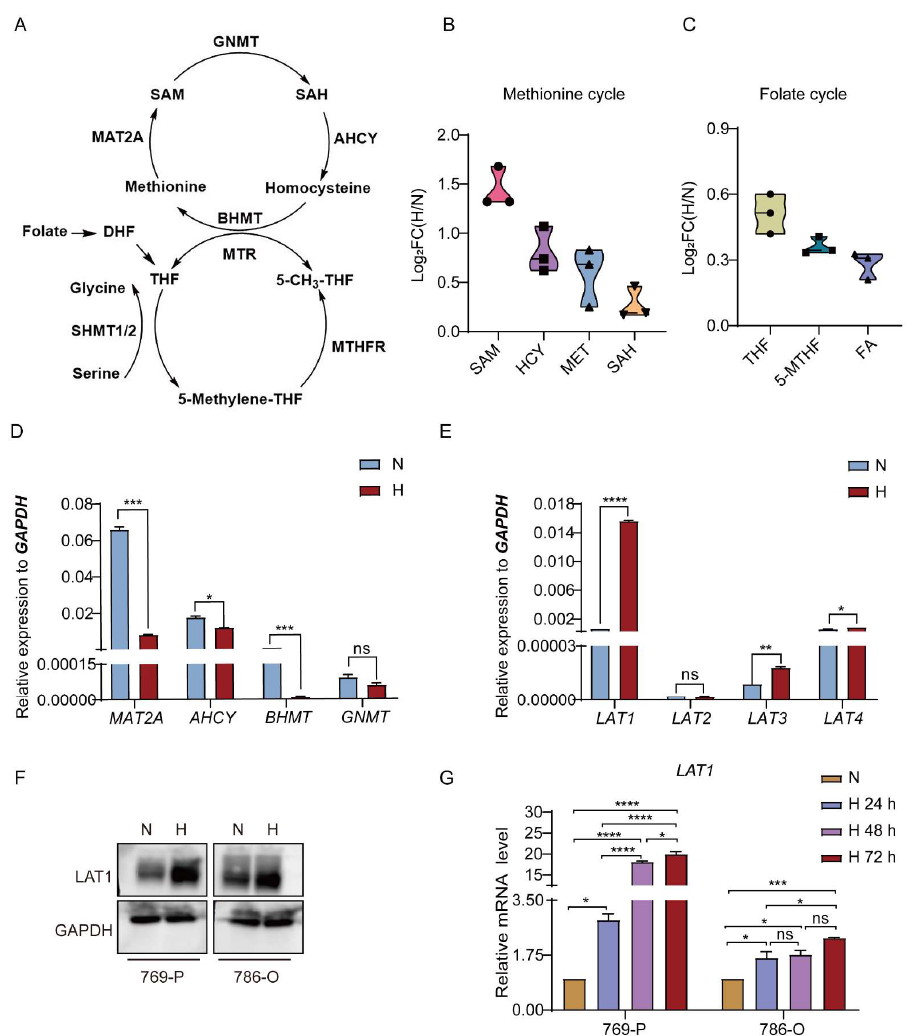
Figure 1. Increased methionine metabolism is mediated by LAT1 upregulation in RCC cells under hypoxia. ( A ) The schema of pivotal metabolites and enzymes in methionine cycle and folate cycle. ( B ) Relative amount of methionine (MET), homocysteine (HCY), S-adenosylhomocysteine (SAH), and S-adenosylmethionine (SAM) in 769-P cells cultured under normoxia and hypoxia for 72 h, respectively. ( C ) Relative abundance of tetrahydrofolate (THF), 5-methyl-tetrahydrofolate (5-MeTHF), and folate (FA) in 769-P cells cultured under normoxia and hypoxia for 72 h, respectively. ( D ) The mRNA expression of pivotal enzymes (MAT2A, AHCY, BHMT, and GNMT) of methionine cycle in 769-P cells cultured under normoxia and hypoxia for 72 h, respectively. MAT2A—Methionine adenosyltransferase 2A; GNMT— Glycine N-methyltransferase; AHCY—Adenosylhomocysteinase; BHMT—Betaine-homocysteine S- methyltransferase. ( E ) mRNA level of methionine uptake transporters (LAT1, LAT2, LAT3, and LAT4) in 769-P cells cultured under normoxia and hypoxia for 72 h, respectively. LAT—L-type amino acid transporter. ( F ) LAT1 protein expression in 769-P and 786-O cells cultured under normoxia and hypoxia for 72 h, respectively. ( G ) RT-qPCR was used to detect the mRNA expression of LAT1 in 786-O and 769-P cells exposing under hypoxic conditions for 0, 24, 48, and 72 h, respectively. FC—fold change; N—normoxia; H—hypoxia. GAPDH was used as an internal control. Data are the mean ± SEM for biological triplicates. Students t -test (two-tailed) and one-way ANOVA analysis were used. * p < 0.05; ** p < 0.01; *** p < 0.001; **** p < 0.0001. ns—no